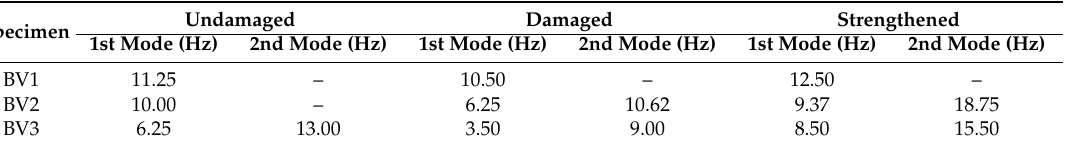
Table 2. Natural frequencies under free oscillation.